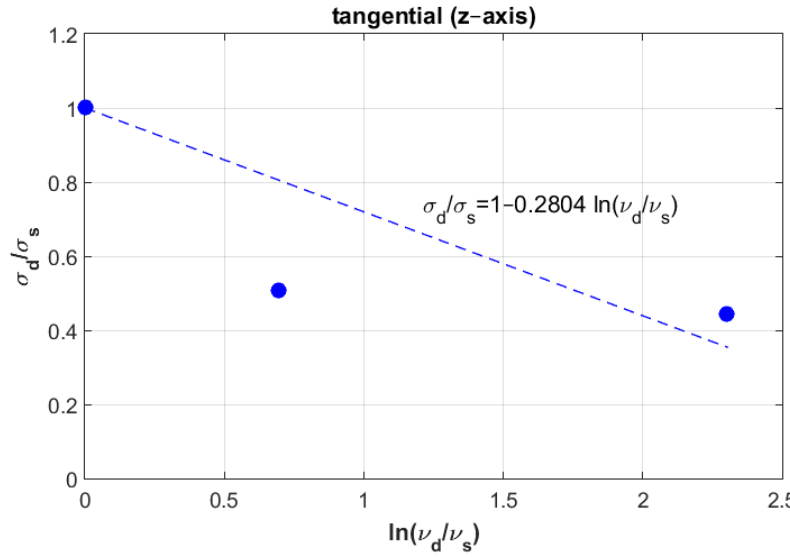
C in the tangential direction (Z). i